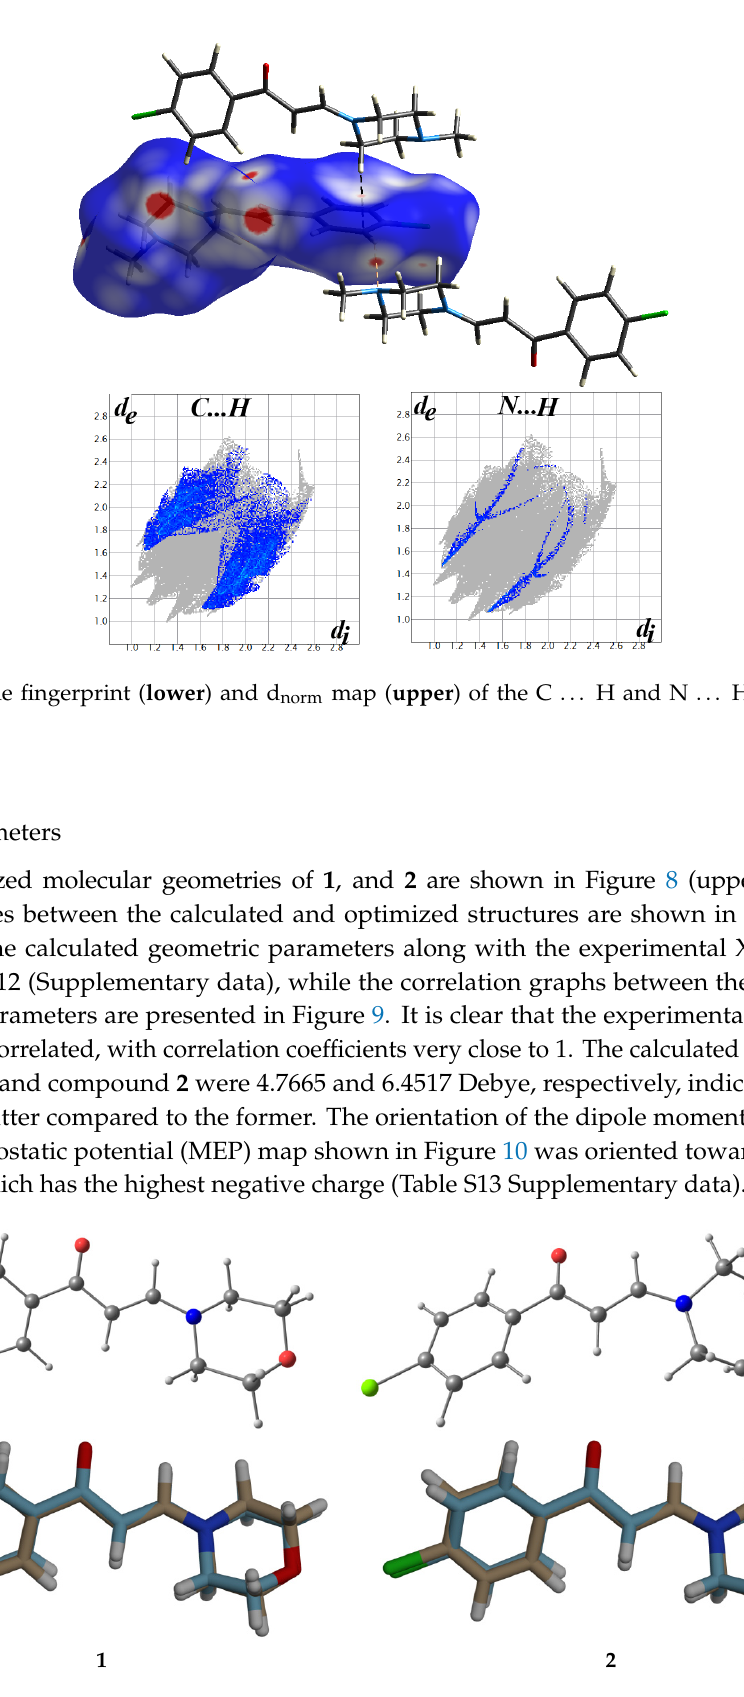
Figure 8. Optimized geometry ( upper ), and optimized / calculated structures overlay ( lower ) for compounds 1 , and 2